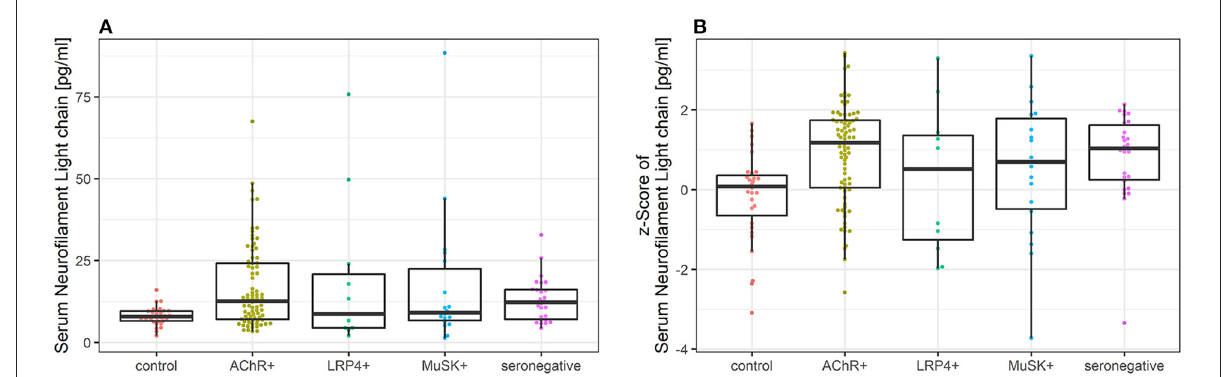
FIGURE1 (A) Comparison of sNfl levels in patients with myasthenia gravis by antibody status and controls. Boxplot of sNfl levels for patients with MG by antibody status in comparison to controls. Anti-AChR-positive patients ( n = 79) had the highest sNfl level with a median of 12.6 pg/ml (IQR 7.0–24.2), followed by seronegative (12.3 pg/ml, IQR 7.0–16.1; n = 26), anti-MuSK-Abs-positive patients (9.1 pg/ml, IQR 6.6–22.4; n = 18), and anti-LRP4-positive patients (8.7 pg/ml, IQR 4.4–20.9; n = 11). (B) Comparison of age-adjusted z-scores of sNfl levels in patients with myasthenia gravis by antibody status and controls using Boxplot of age-adjusted z-scores of sNfl levels in MG patients by antibody status in comparison to controls. The z-scores quantify the deviation of sNfl in comparison to controls of the same age based on a reference database of sNfl measured in 4,532 persons. AChR- + , acetylcholine receptor antibody positive MG-patients, Abs, antibody, IQR, interquartile range, LRP4 + , lipoprotein related peptide 4 positive MG-patients, MuSK + , muscle specific positive MG patients, sNfl, serum neurofilament light chain.